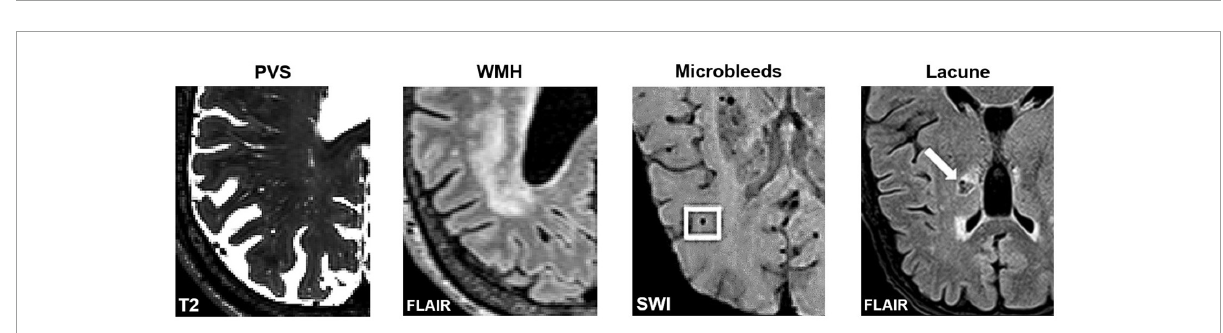
FIGURE4 Axial slices of MRI-visible brain lesions, including PVS, white matter hyperintensities, microbleeds, and lacunes. PVS appear as hyperintense and tubular shapes in T2-weighted MRI scans (Left) . White matter hyperintensities are prominent on FLAIR images (Middle-Left) . Other lesions that can be confused with PVS include microbleeds (Middle-Right) and lacunes (Right) . In FLAIR scans, lacunes are surrounded by a hyperintense rim, whereas PVS are not. Imaging artifacts such as Gibbs ringing, and motion artifacts can also hinder the automated detection of PVS. Figures of microbleeds and lacunes were adapted from Chesebro et al. (2021) and Li et al. (2019), respectively. The figures are reproduced under the Creative Commons Attribution 4.0 International License (https://creativecommons.org/licenses/by/4.0/). FLAIR, Fluid attenuated inversion recovery; SWI, susceptibility-weighted